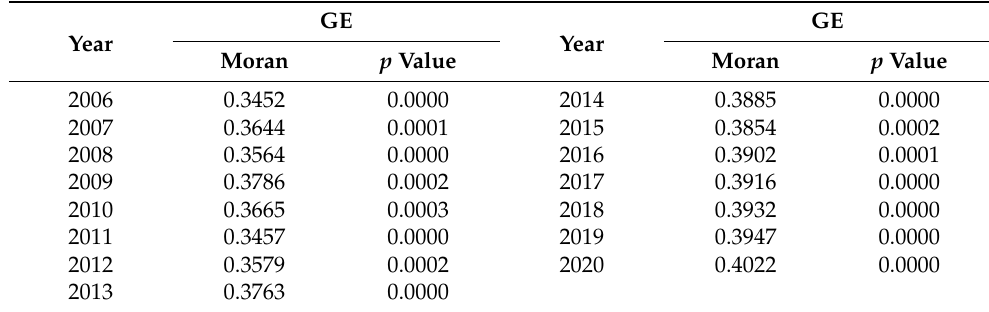
Table 5. Spatial autocorrelation test